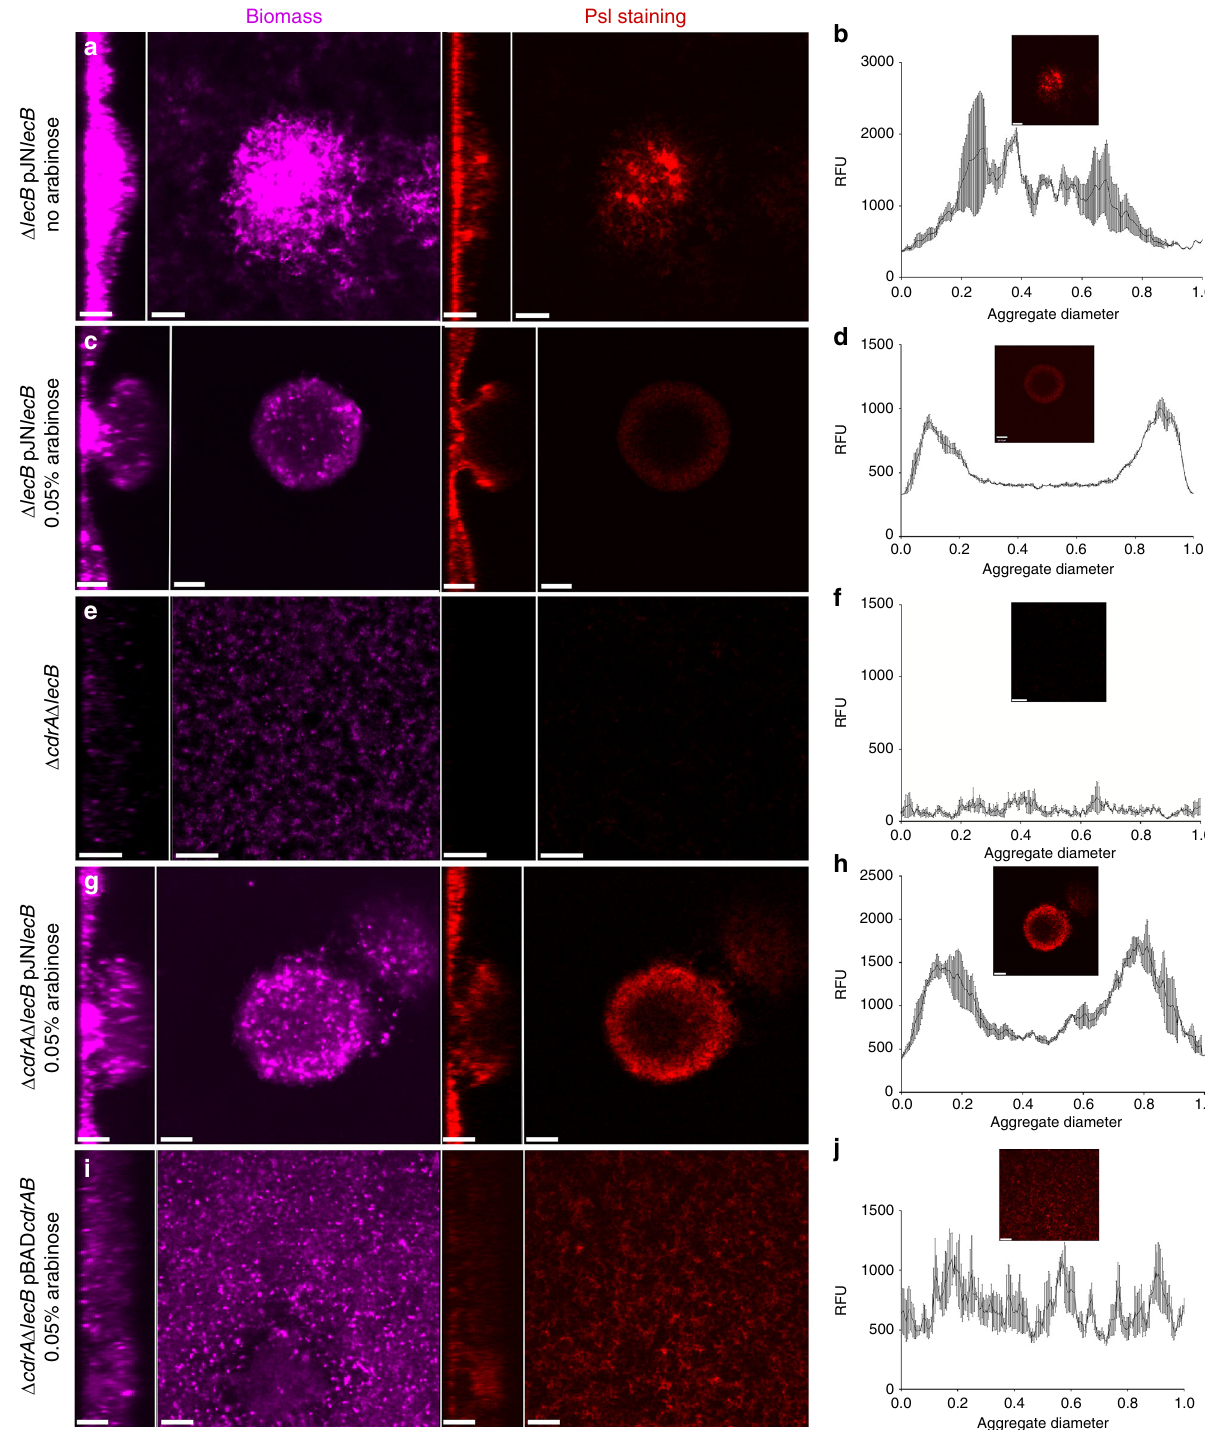
Fig. 6 LecB coordinates Psl positioning in the matrix. a Syto 62 (magenta) and HHA-TRITC (red) stained bio fi lms of Δ lecB pJNLecB grown in NB without arabinose forms a fl at bio fi lm with b Psl distribution being fairly homogenous throughout the biomass (the x -axis, RFU, corresponds to the intensity of PSL staining.). Psl intensity pro fi les were generated from an average of nine independent micrographs. Inset is a representative Psl staining micrograph that was used to generate the pro fi le. c Bio fi lms of Δ lecB pJNLecB grown in NB with the addition of 0.05% arabinose present a similar structure and d Psl distribution to the ones formed by PAO1. e Syto 62 (magenta) and HHA-TRITC (red) stained bio fi lms of Δ cdrA Δ lecB pJNLecB grown in NB without arabinose display a loose carpet of cells with f no particular Psl localization pattern. g Δ cdrA Δ lecB pJNLecB grown in NB with the addition of 0.05% arabinose rescues PAO1 phenotype and h usual Psl placement. i Bio fi lms of Δ cdrA Δ lecB pBADCdrAB grown in NB with the addition of 0.05% arabinose results in the formation of an undifferentiated thick layer of cells with j no particular Psl organization. Psl distribution measurements were performed in nine images from three different experiments per condition. Scale bars = 25 µ